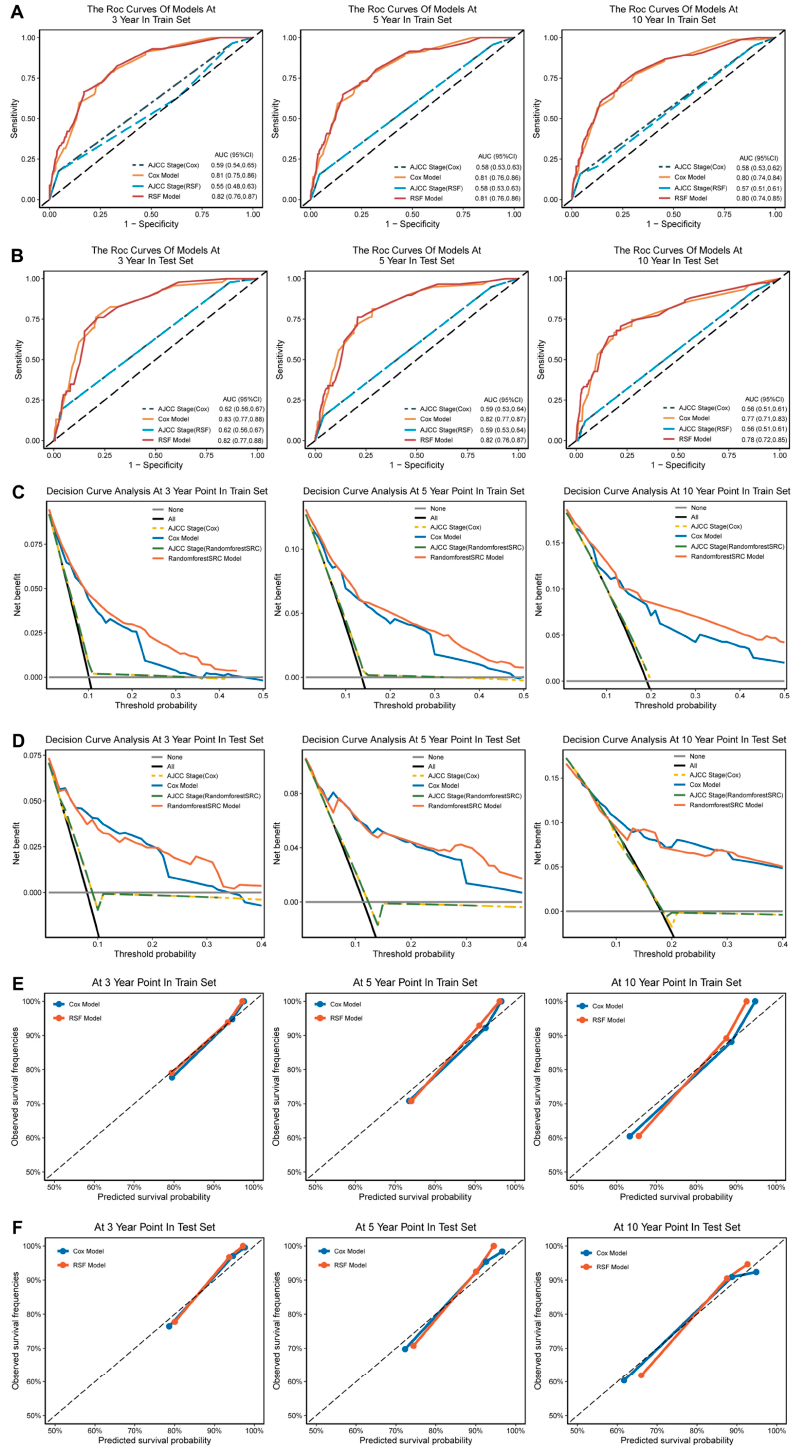
Figure 4. Validation and calibration of models. ( A ) The ROC curves showed that both the Cox